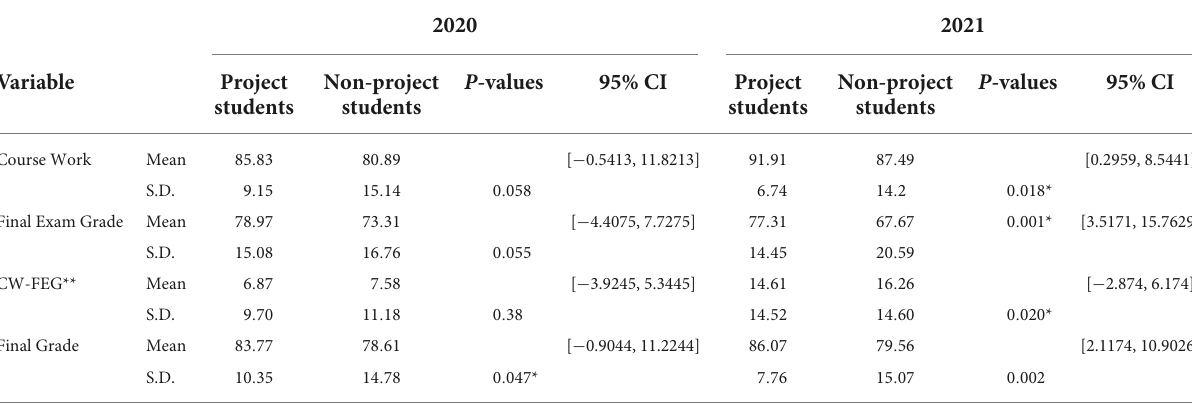
TABLE 2 Student attainment variables and the results of t